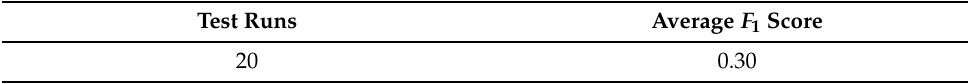
Table 6. ISFB Similarity Using BusyBox Features.